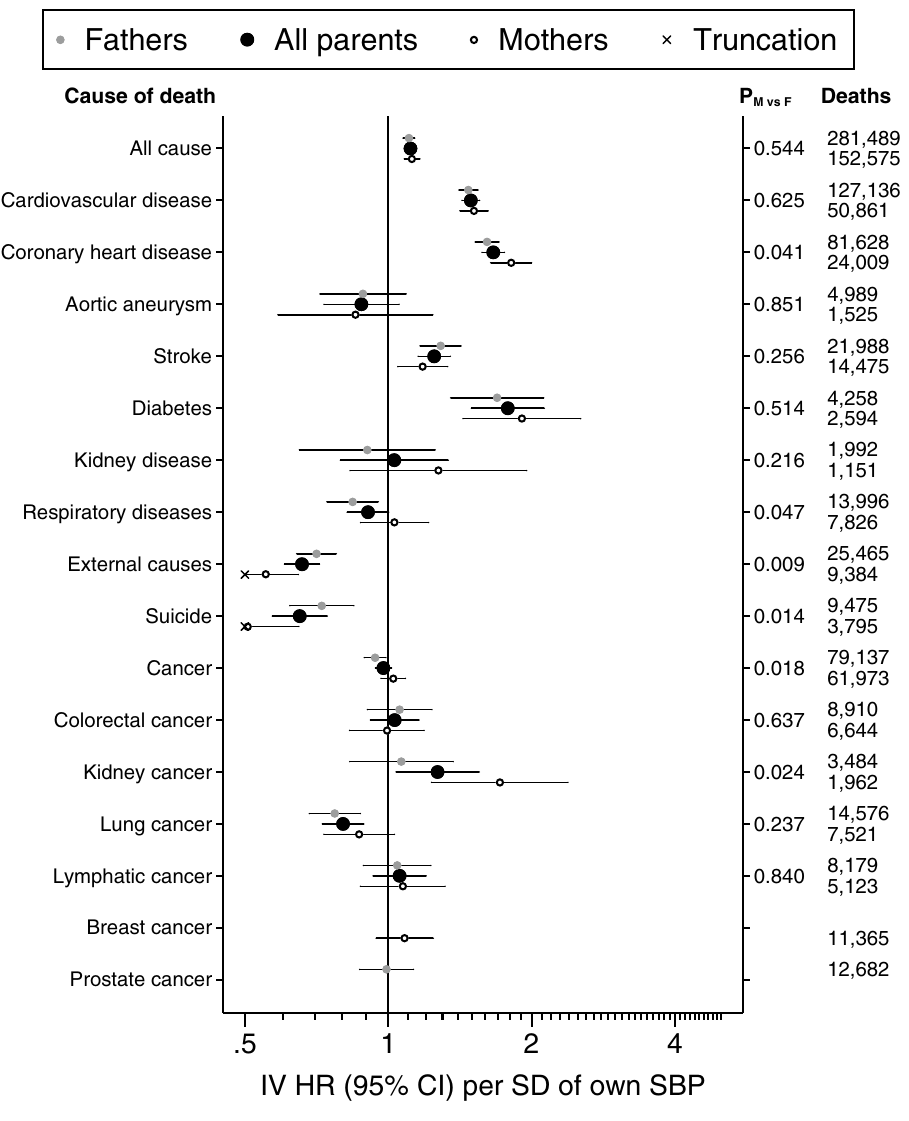
Figure 1. A correct version of the original Figure